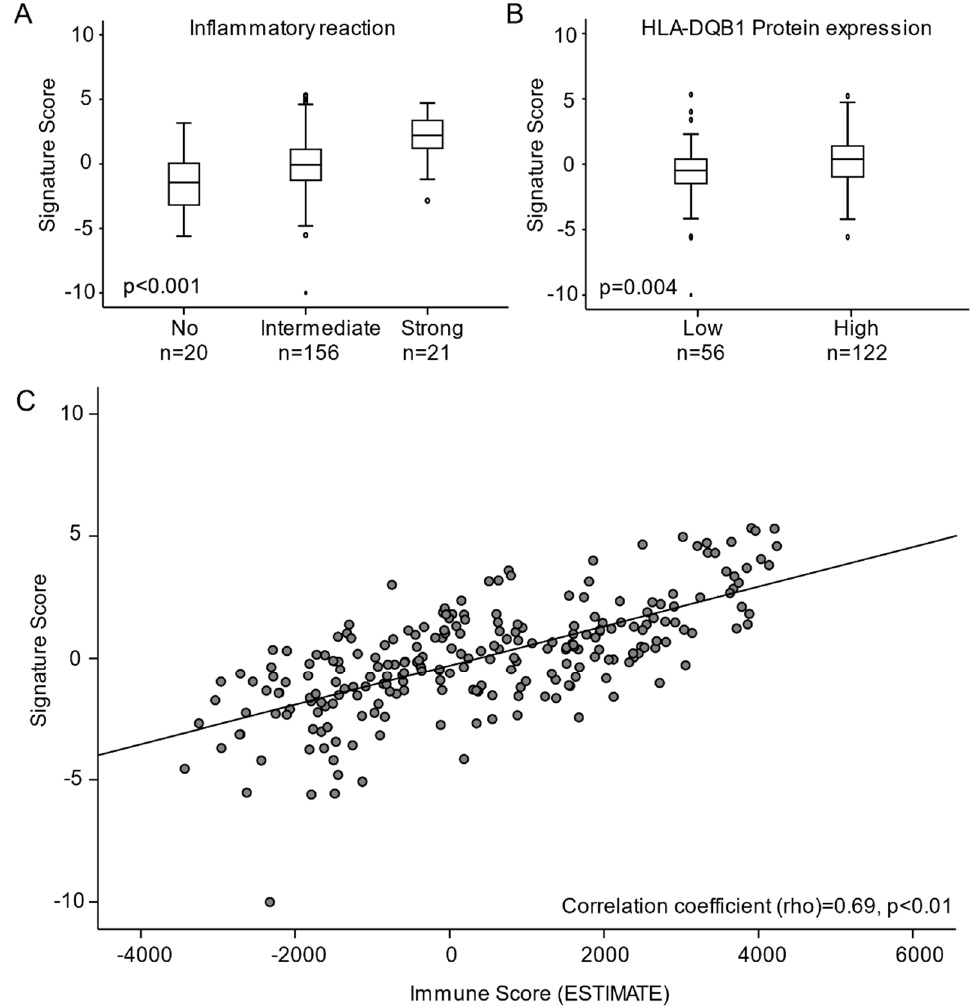
Figure 4. Signature score in relation to ( A ) inflammatory reaction ( B ) HLA-DQB1 protein expression and ( C ) immune score (ESTIMATE). Abbreviations: ESTIMATE: Estimation of Stromal and Immune cells in MAlignant tumor tissue using Expression.